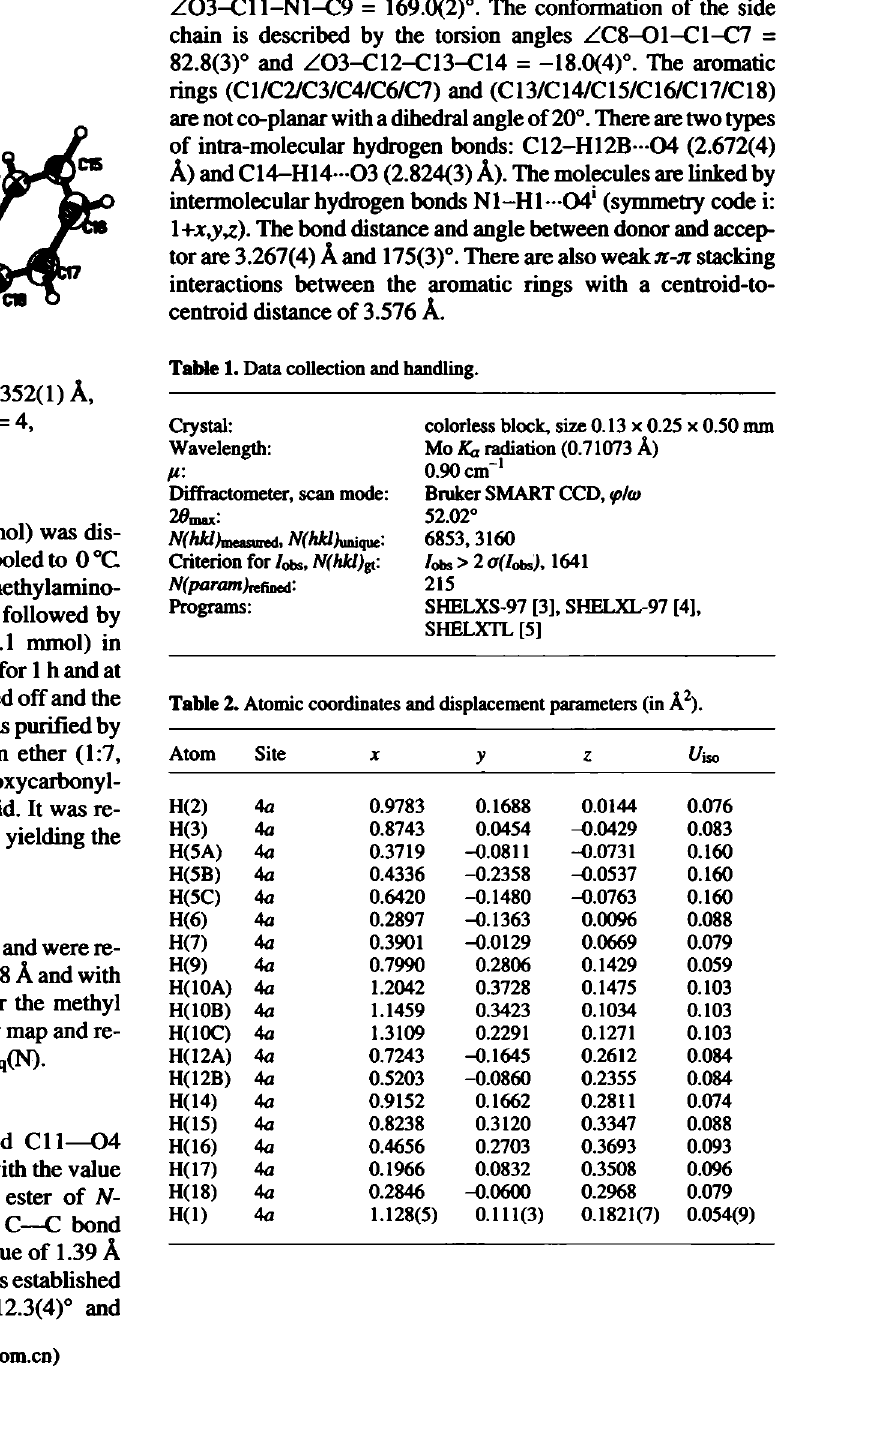
Table 1. Data collection and handling.